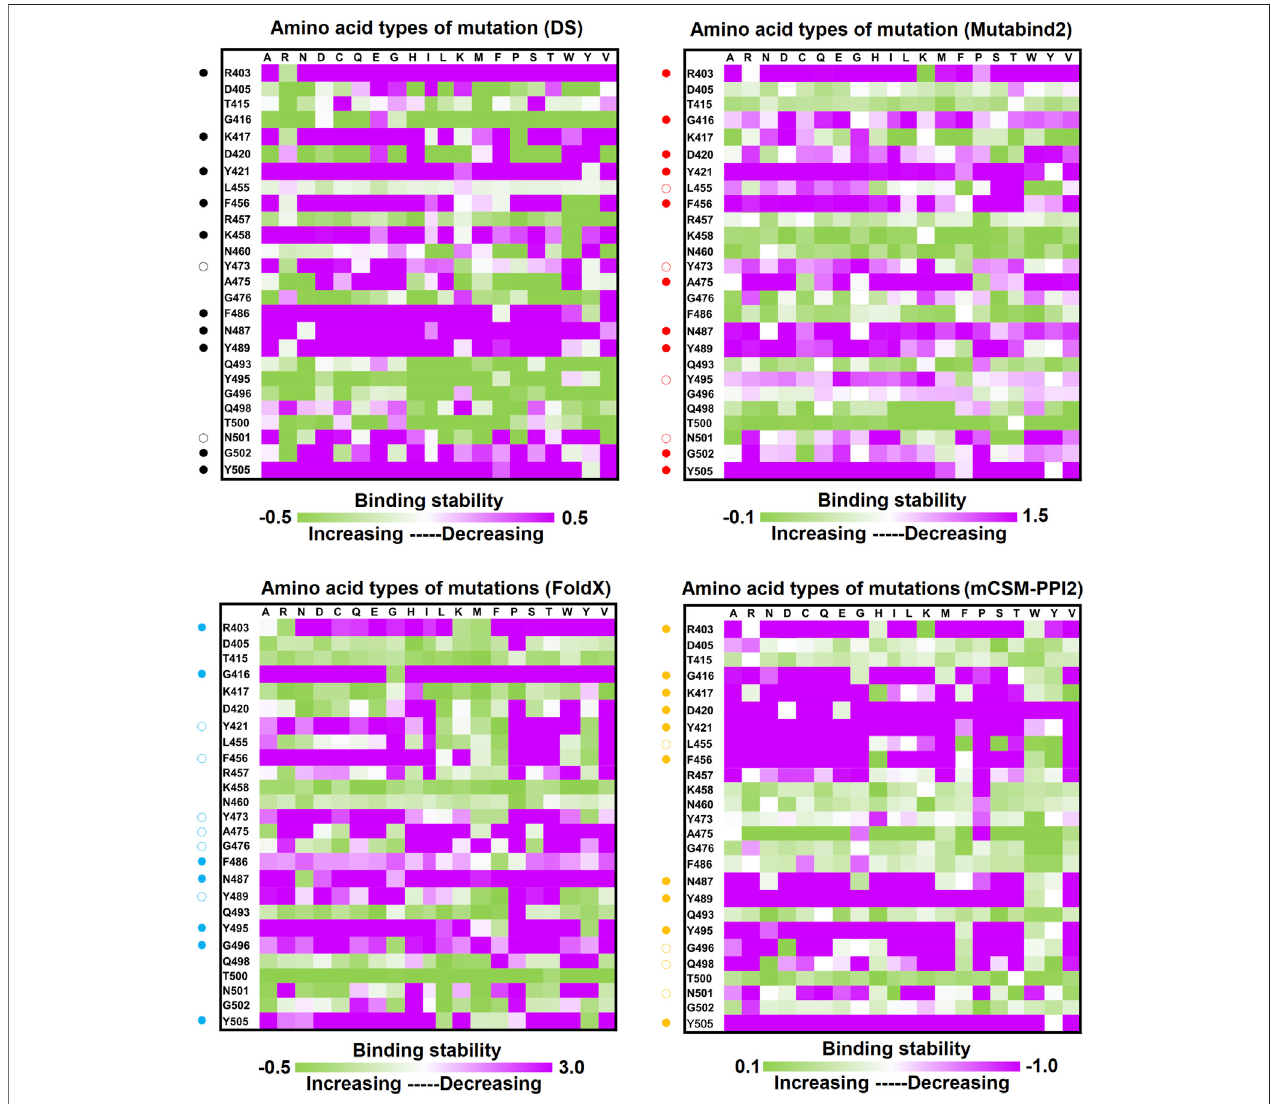
FIGURE 4 | Mutational heatmaps of the RBD targeting antibody B38. The mutational binding stabilities of RBD variants to B38 were estimated using FoldX, MutaBind2, DS 3.5, and mCSM-PPI2. The unit of binding stability was kcal/mole, and the obtained values were employed to create the heatmaps. Green (increased stability) and purple (reduced stability) were used to generate a color gradient and were applied in each box. In each heatmap, the moderately and signi fi cantly reduced stabilities are labeled with hollow and solid circles, respectively.